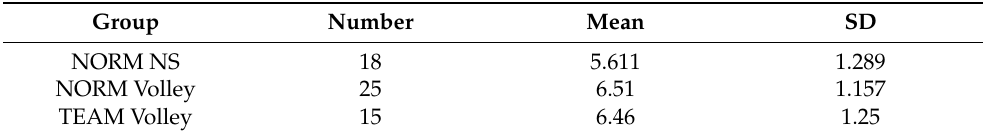
Table 3. Average values and standard deviations for the Corsi’s test score in NORM NS, NORM volley and TEAM volley with the same age and the same athletic skill level.